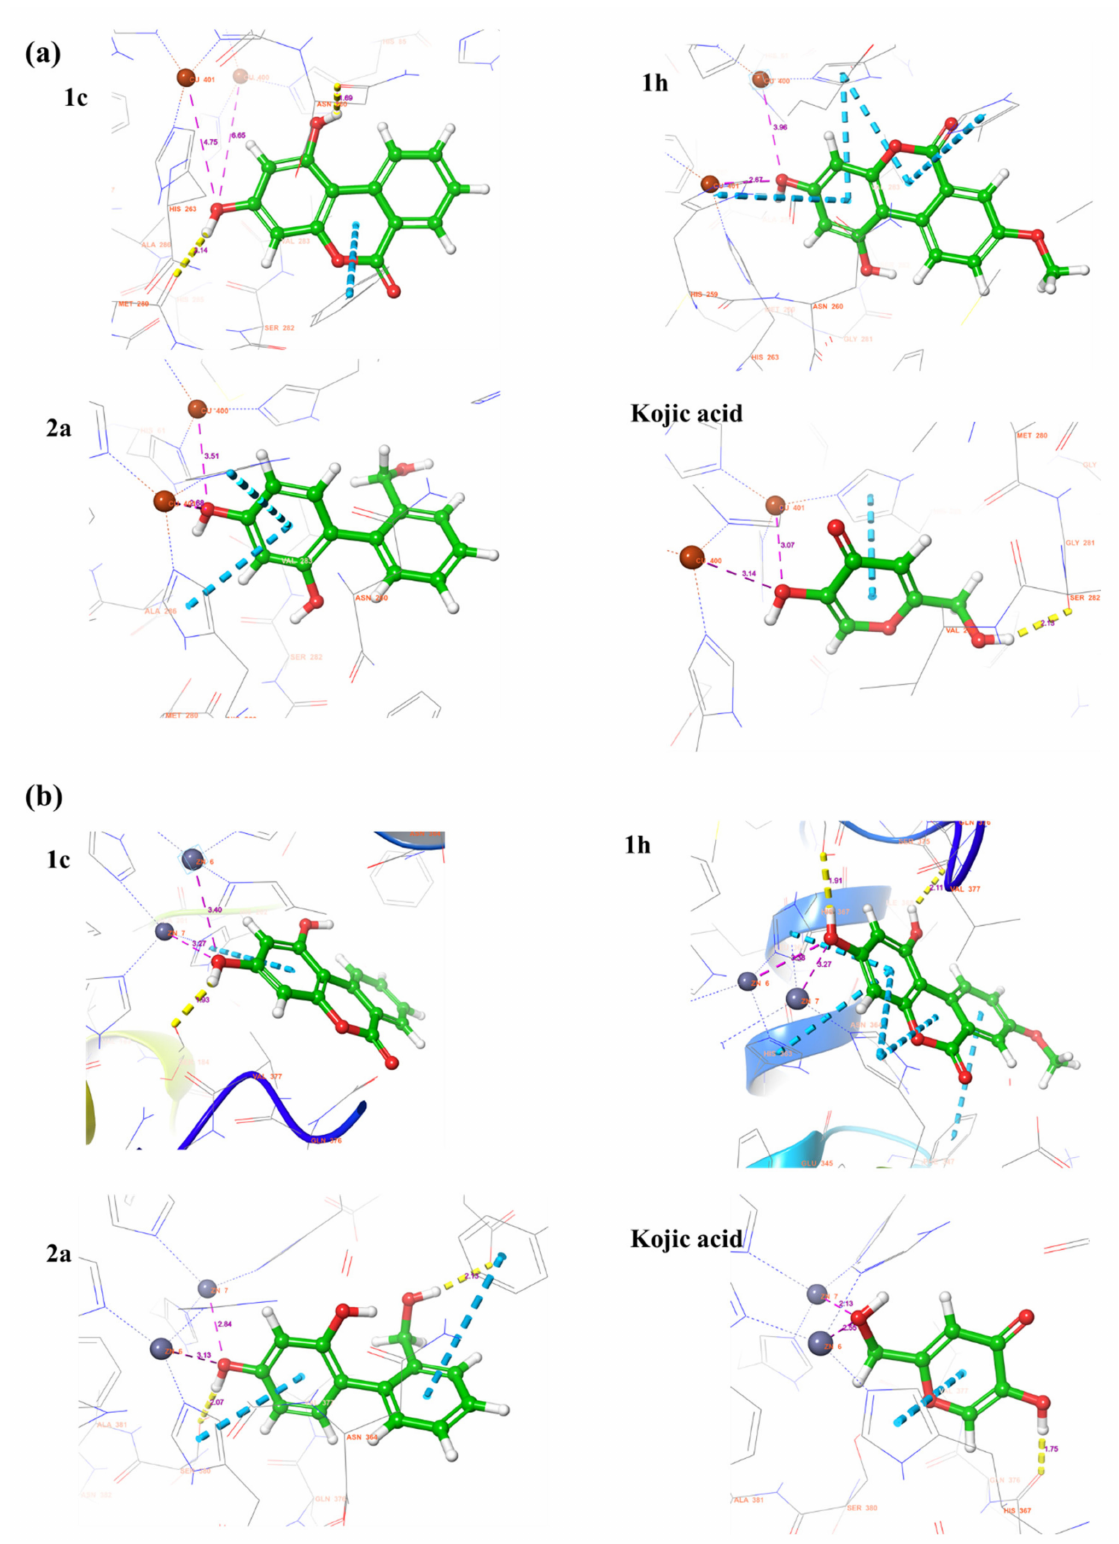
Figure 9. Binding analysis between tyrosinases and compounds 1c, 1h, 2a or kojic acid based on the results obtained from Schrödinger Suite. ( a ) Interactions with 1c, 1h, 2a and kojic acid in mushroom tyrosinase. ( b ) Interactions with 1c, 1h, 2a and kojic acid in human tyrosinase. The distance between interacting atoms is expressed in angstroms